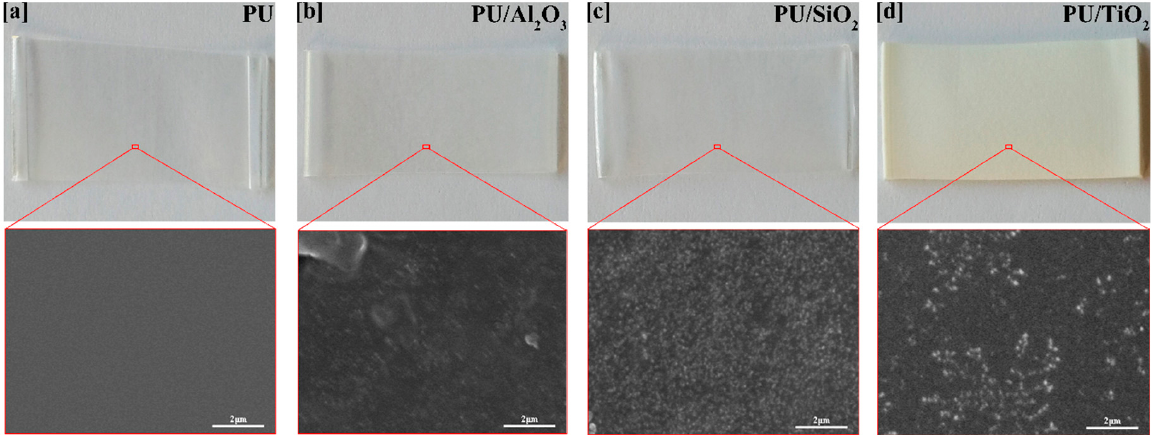
Figure 2. Photos of different samples and scanning electron microscope (SEM) images of the PU, PU/ceramic embedded films: ( a ) PU, ( b ) PU/Al 2 O 3 , ( c ) PU/SiO 2 , and ( d ) Pu/TiO 2.